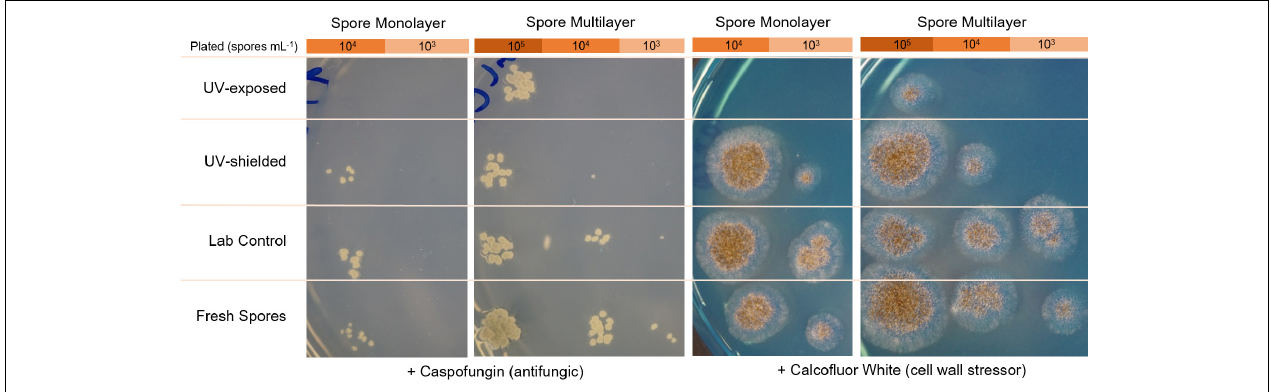
FIGURE 9 | Stress resistance of A. niger towards caspofungin (antifungal compound) and to calcofluor white (cell wall stressor), after spore exposure to simulated martian conditions. TABLE 4 | Impact of spore monolayer versus spore multilayer in A. niger resistance to Mars-like conditions. Monolayer Multilayer f p